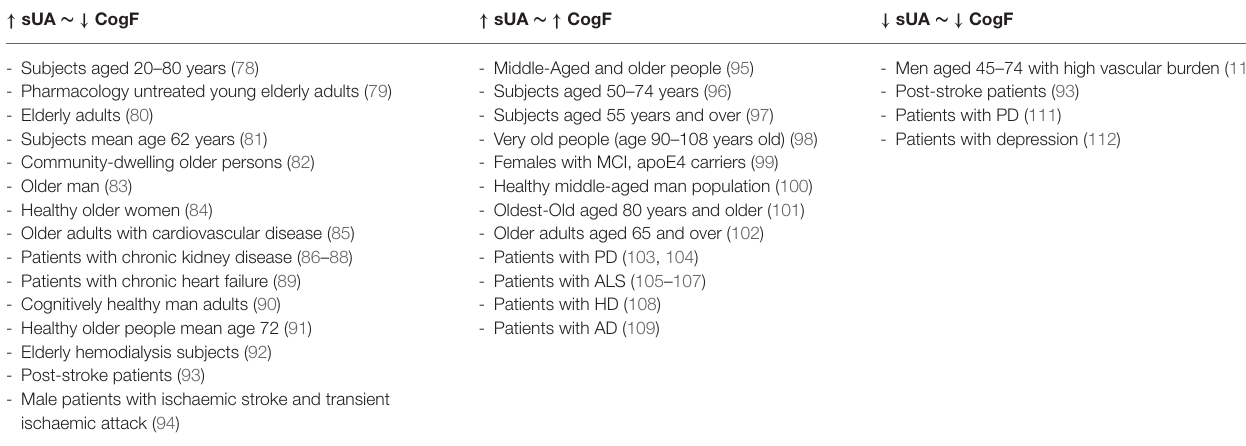
TABLE 1 | Correlation between serum uric acid levels (sUA) and cognitive functioning (CogF) in various study populations. ↑ sUA ∼ ↓